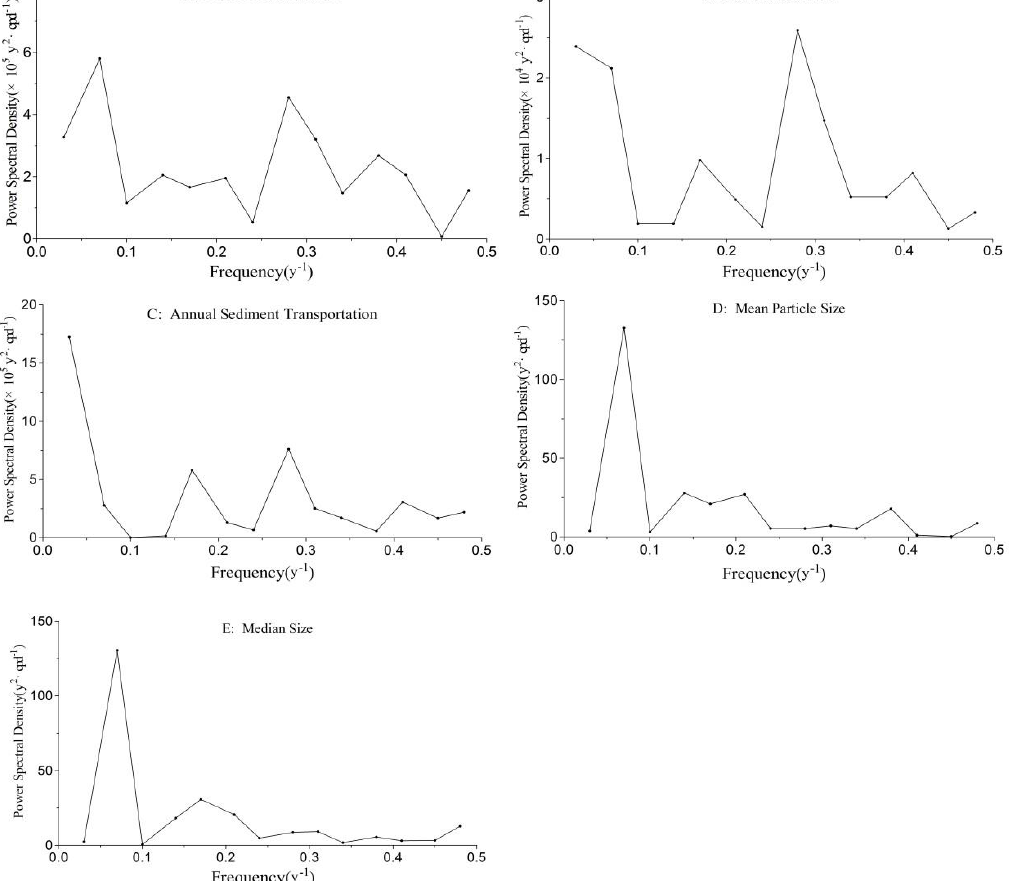
Figure 5. Spectrum analysis of the Liaohe River runoff index and the sediment particle size parameters of the tidal flat sediments in the Liaohe estuary wetland.